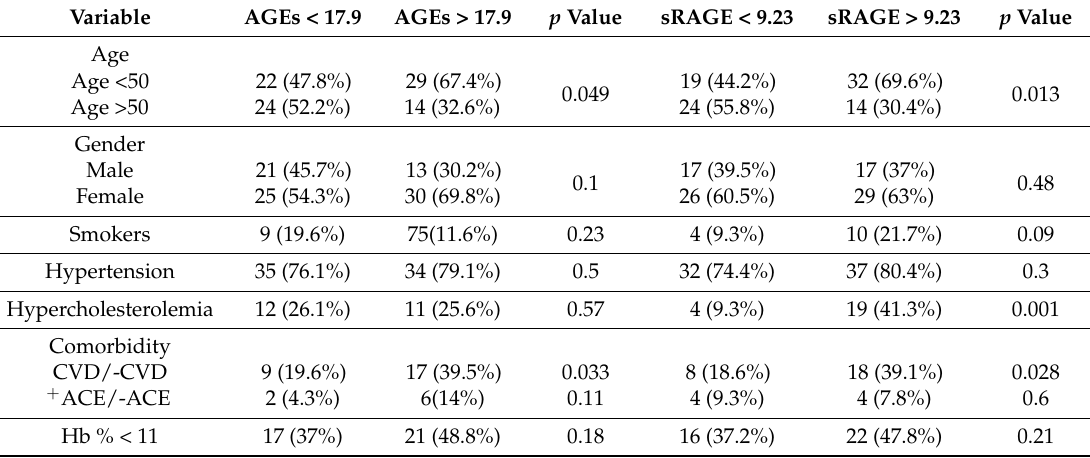
Table 4. Baseline characteristic of HD DM − patients according to AGEs and sRAGE (median level).